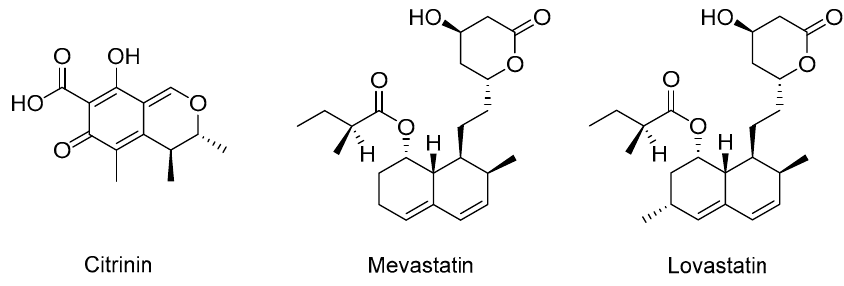
Figure 4. Chemical structures of natural inhibitors of cholesterol biosynthesis.